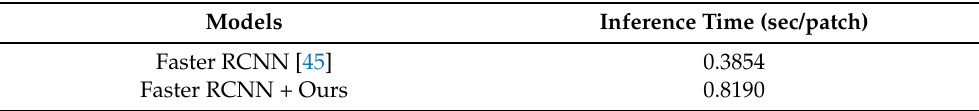
Table 4. Comparison of running times for the time complexity analysis. We evaluated the running times on a patch image sized 800 × 800 with a Titan Xp